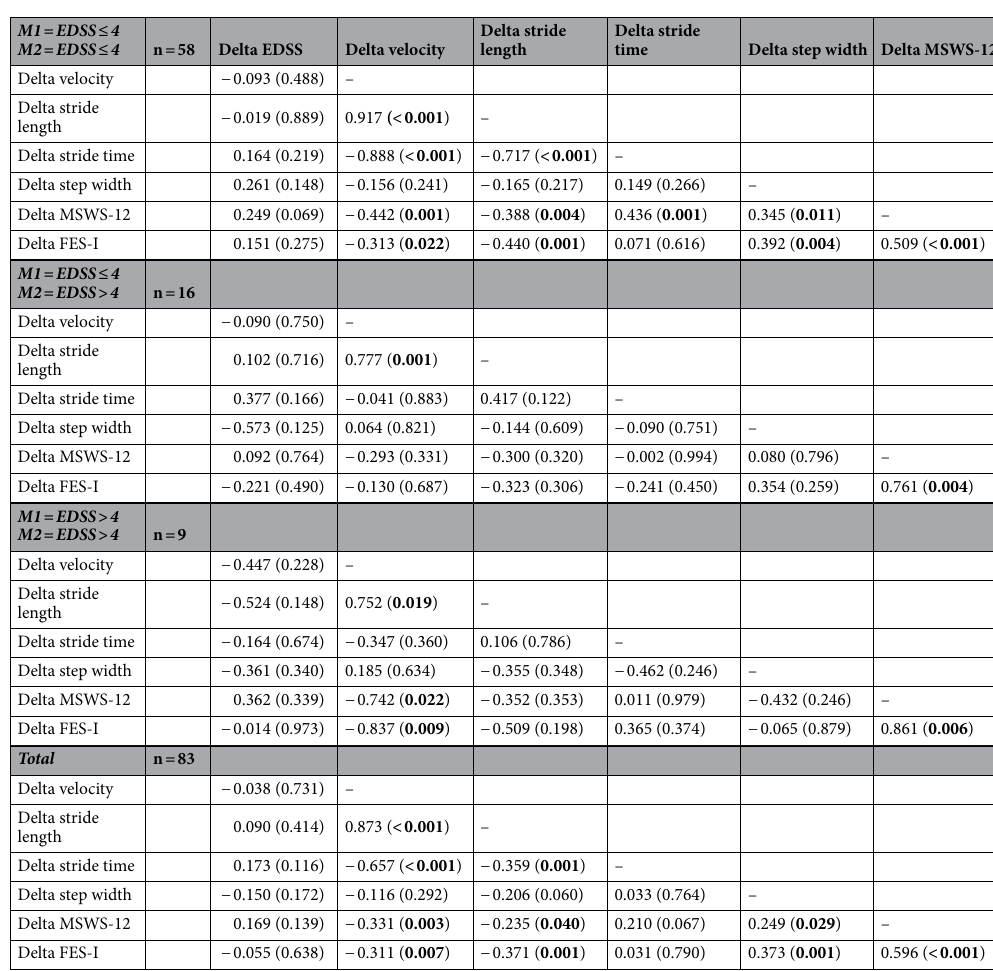
Table 2. Pearson’s correlation coefficient ( p value) between absolute changes in disability and mobility outcome measures. Significant values are in